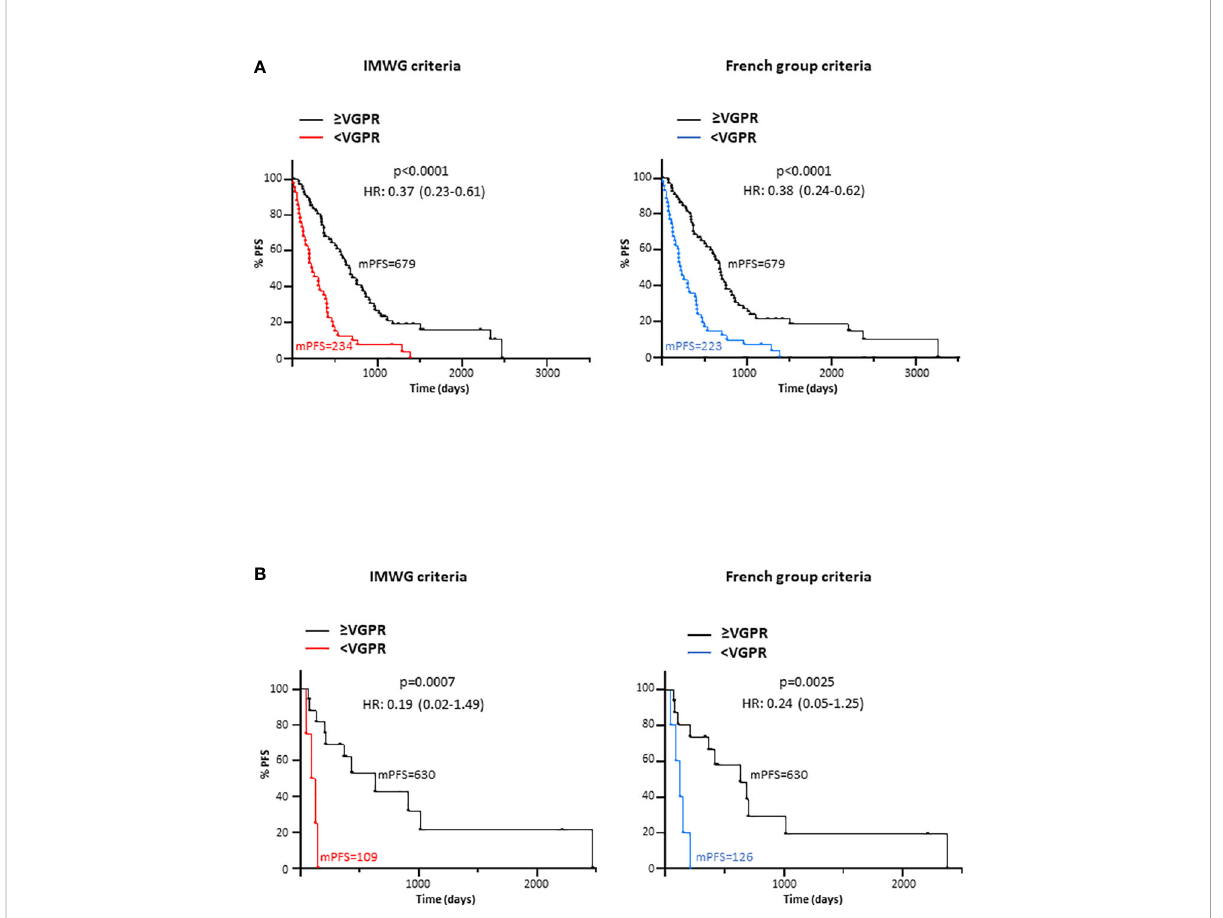
FIGURE 3 Progression-free survival (PFS) according to the depth of response ( ≥ VGPR or <VGPR) achieved at maximum response attending to the IMWG and the French group criteria in (A) the entire cohort and (B) only in LCMM patients. HR, Hazard ratio; IMWG, International Myeloma Working Group; mPFS, median progression-free survival; VGPR, very good partial